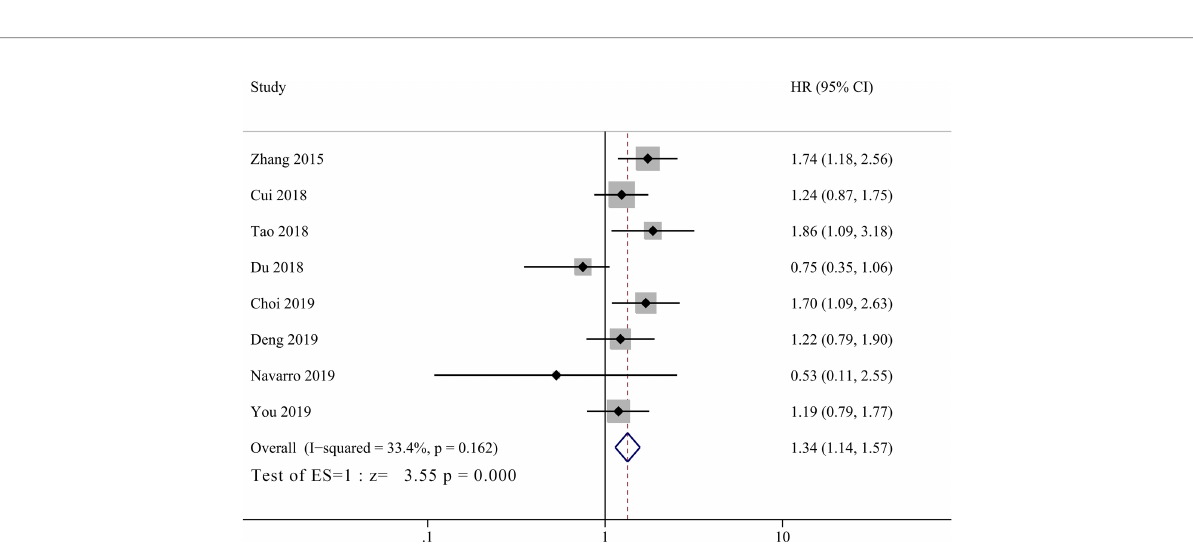
FIGURE 4 | Forest plot for the association between platelet-to-lymphocyte ratio (PLR) and overall survival of patients with Gallbladder carcinoma